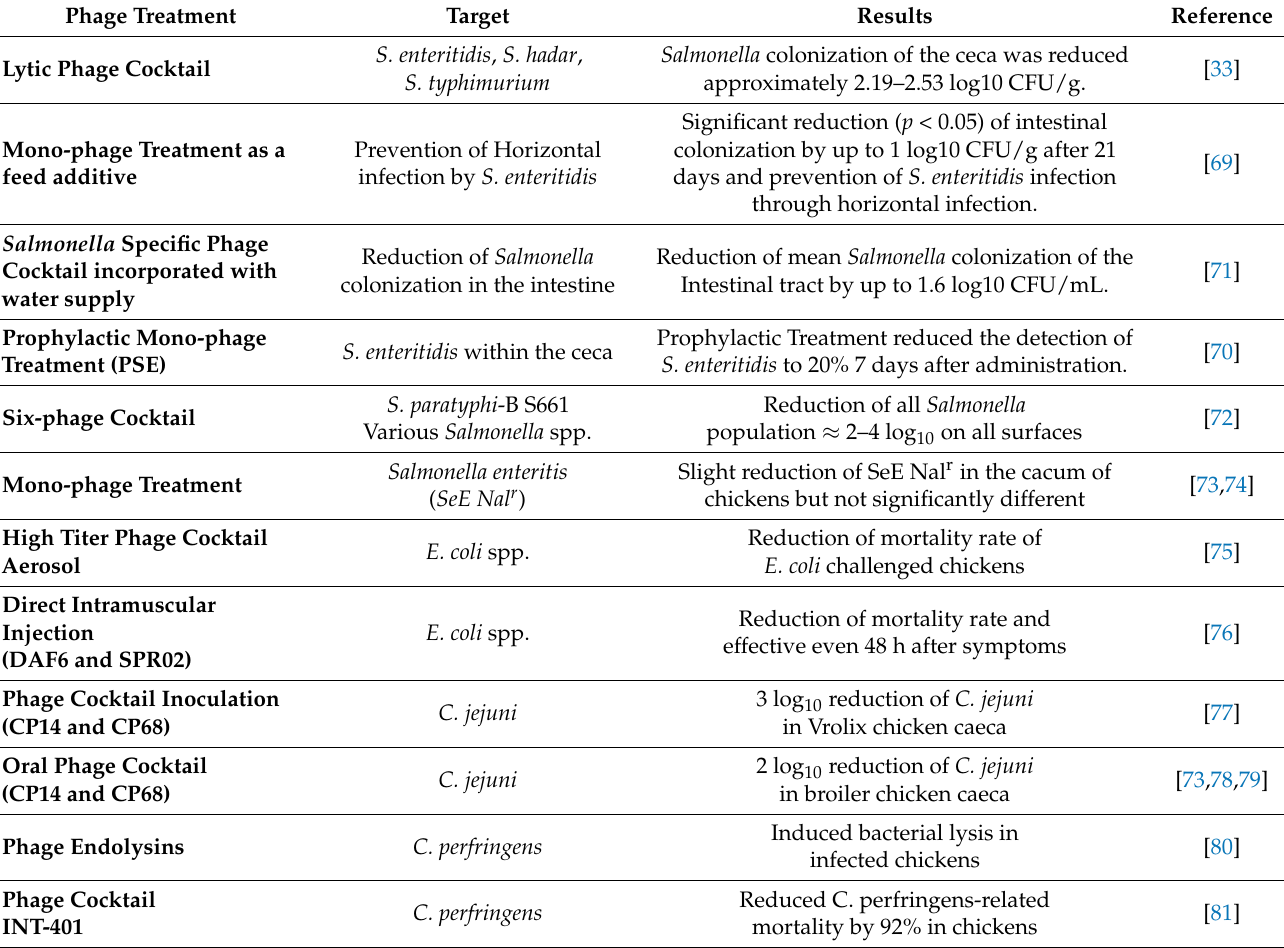
Table 2. Phage Biocontrol Studies. The studies referenced in Table 2 outline several methods in which phages can be utilized for the prevention and control of Salmonella , E. coli , Campylobacter , and Clostridium within food sources [68–70]. The versatility of phage therapy as a preventative treatment as well as a therapeutic is a benefit not possessed by typical chemical intervention